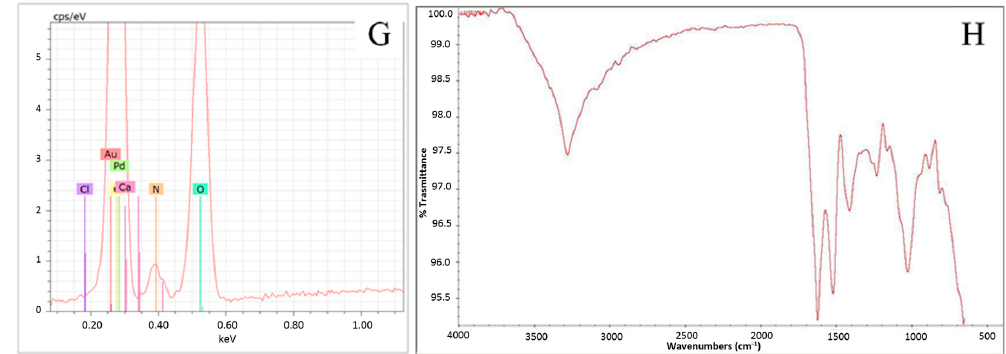
Figure 4. Morphological and physico-chemical characterization of AMs ( A – D ) and FAMs ( E – H ). Scanning electron microscope (SEM) images: AMs smooth surface ( A , B ) and FAMs rough surface ( E , F ); energy dispersive X-ray (EDX) spectra: fibroin nitrogen peak in FAMs spectrum ( G ), and absence of the fibroin nitrogen peak in AMs spectrum ( C ); Fourier transform infrared spectroscopy (FTIR) spectra: ( D ) AMs calcium alginate peak stretching vibrations of O–H bonds in the range 3000–3600 cm ⁻ 1 , stretching vibrations of aliphatic C–H at ~2900 cm ⁻ 1 and asymmetric stretching vibration of the carboxylate group at ~1600 cm ⁻ 1 ( D ); ( H ) absorption bands of FAMs fibroin crystalline β -sheets conformation at ~1620 cm ⁻ 1 for Amide I and ~1520 cm ⁻ 1 for Amide II.